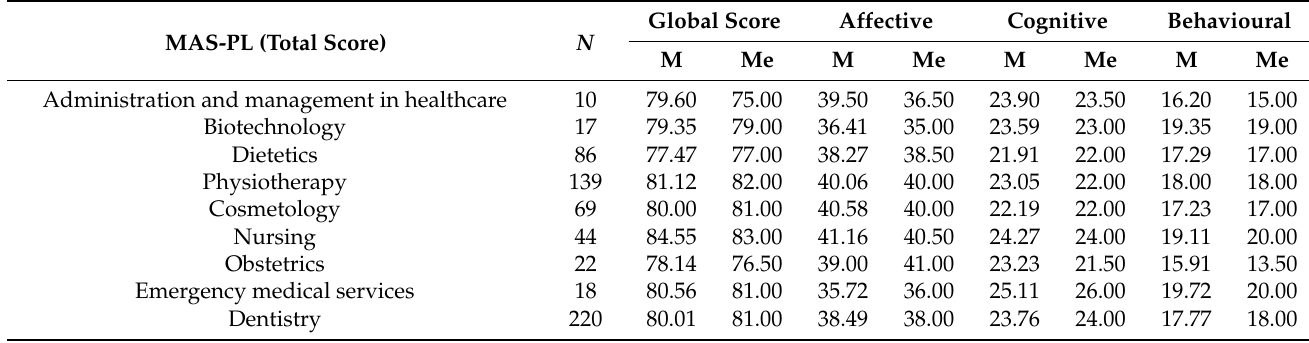
Table 5. Descriptive analysis of the MAS-PL scores (total score, affective, cognitive and behavioural subscales) by major of study.